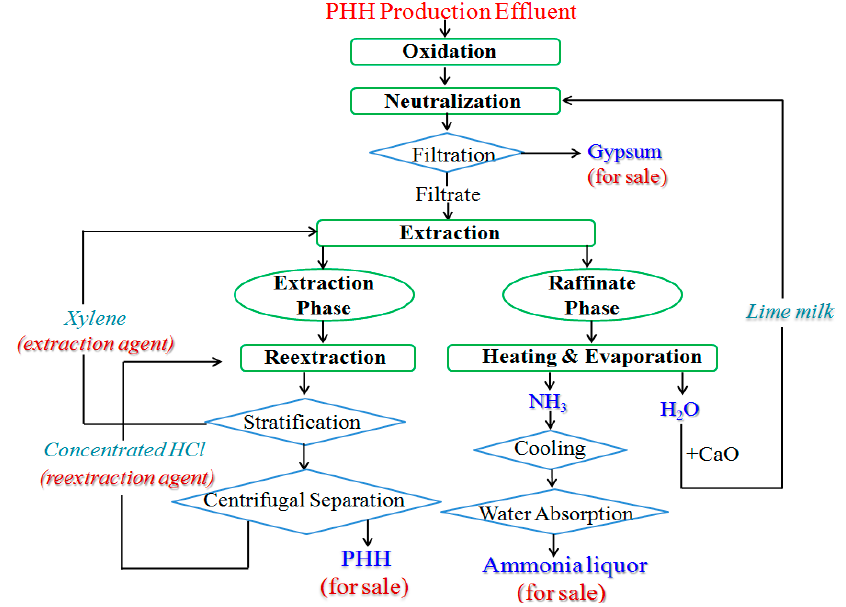
Figure 1. Schematic diagram of treatment process of PHH effluent.